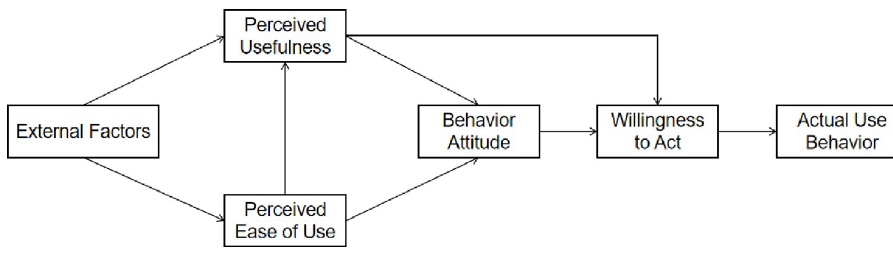
Fig 1. Technology acceptance